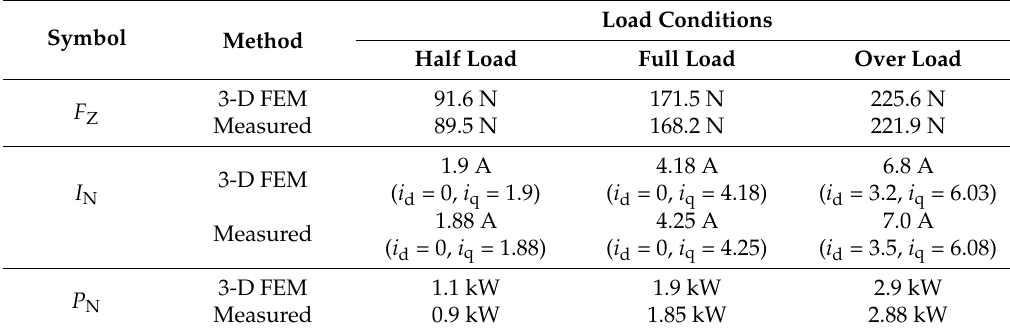
Table 3. Parameter comparison between simulated and experimental results.